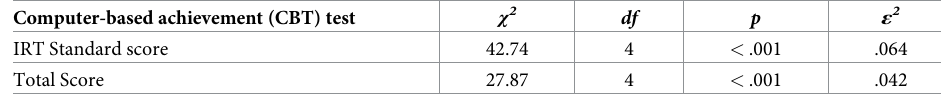
Table 4. Summary of Kruskal–Wallis test score comparison, 2017–2021.